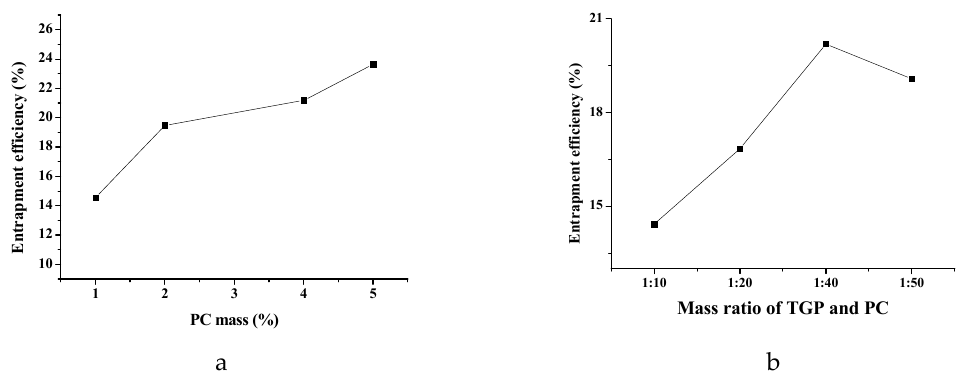
Figure 1. Effects mass ratio of PC, and mass ratio of TGP and PC on EE. ( a ) mass ratio of PC; ( b ) mass ratio of TGP and PC ( n = 3).